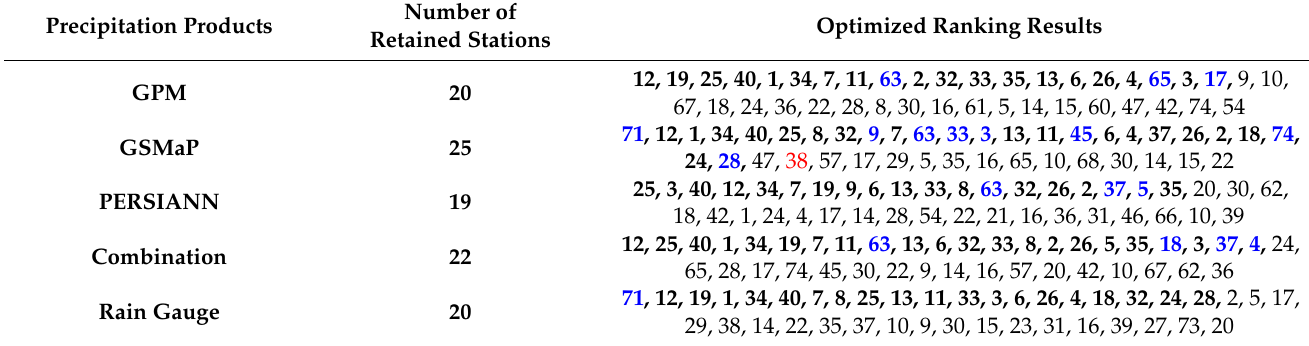
Table 2. Optimized ranking results of 75 rain gauge stations in the network (showing only the top 40